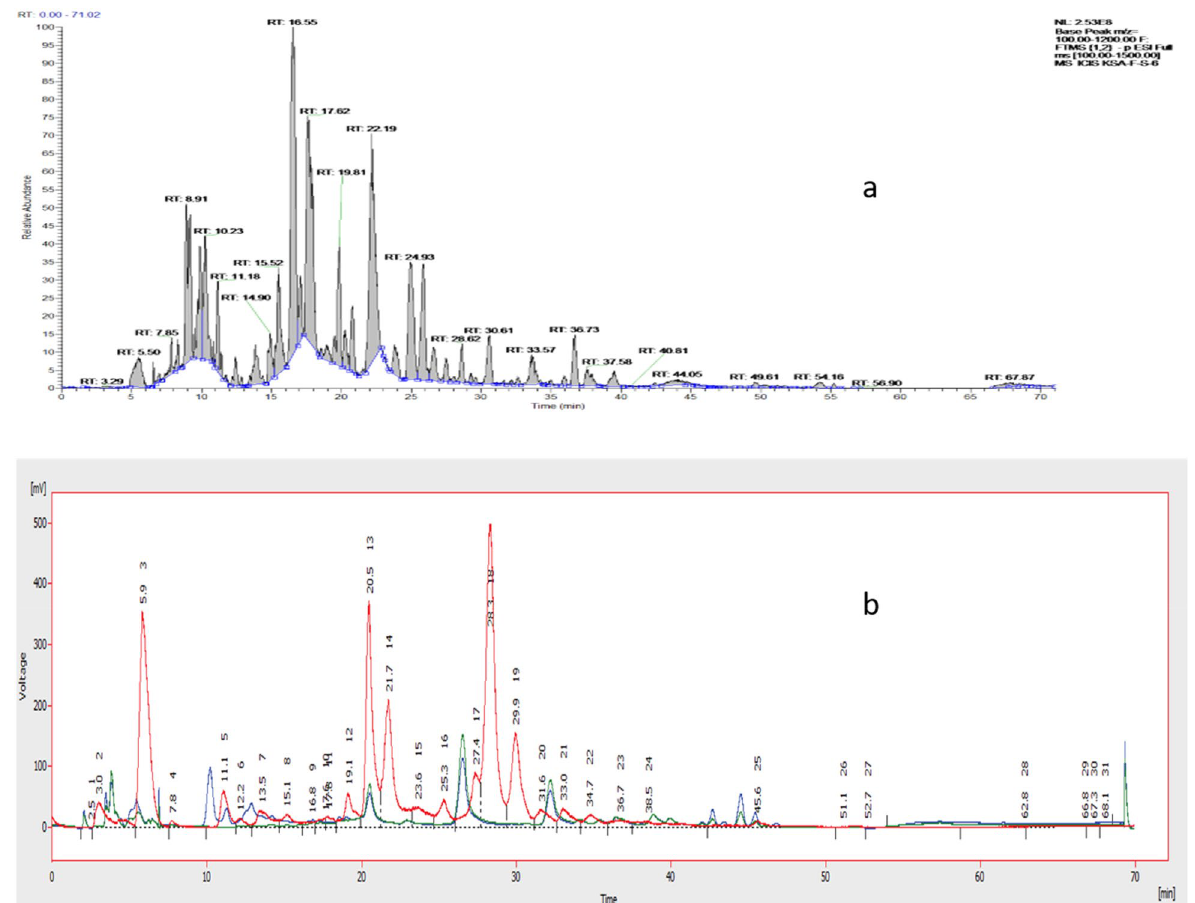
Figure 2. LC–MS Chromatogram of Saudi’s crude propolis fraction (S-6) using ( a ) ESI; ( b ) ESD (compounds were mostly UV-absorbing, that could be flavonoids or phenolic with retention times of 40 and 60 min (red and blue spectra corresponds to flavanoids detected at 290 and 320 nm respectively); Terpenoids or fats or any other compounds without chromophores (green trace) were also detected but with low